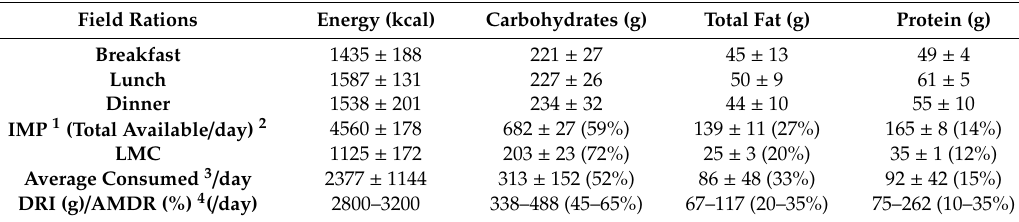
Table 3. Energy and nutrient intakes from field ration consumed and discarded during the arctic-like field training exercise (n = 10).